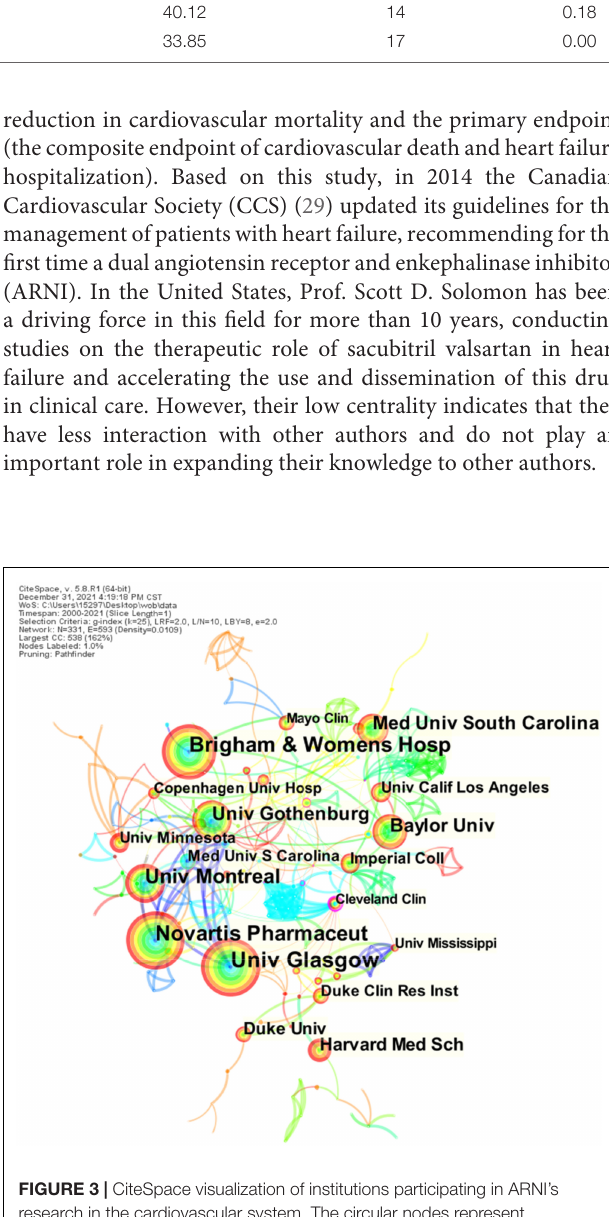
Frontiers in Cardiovascular Medicine |